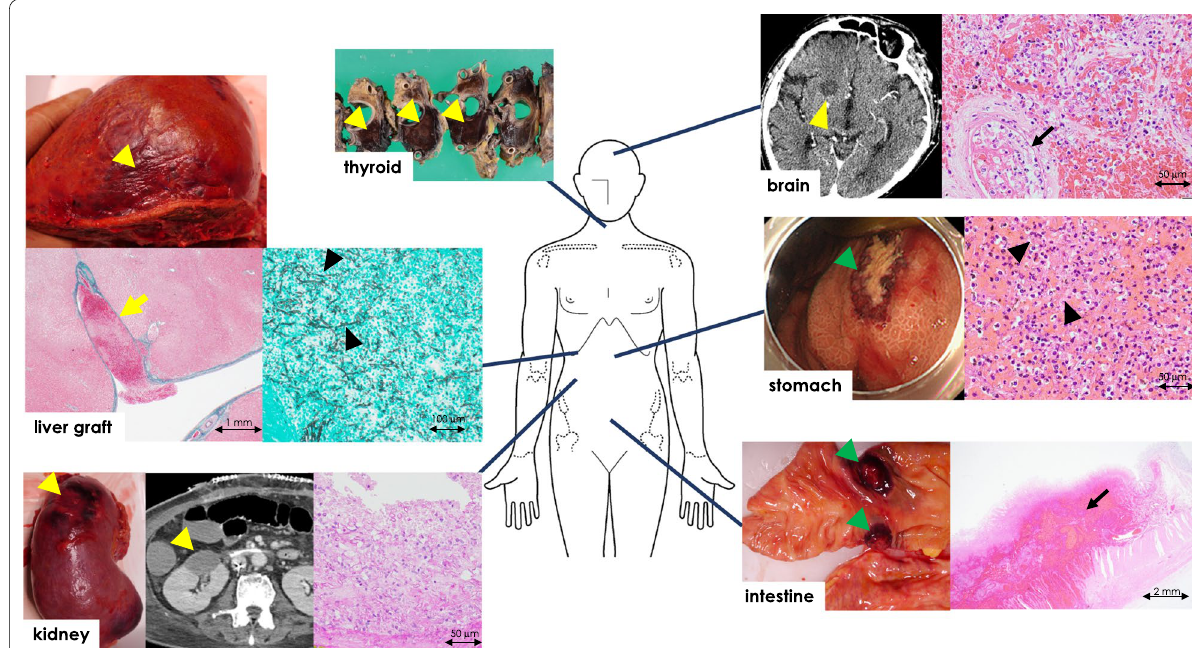
Fig. 4 Autopsy findings. The brain, thyroid, liver graft, and kidney have infarctions (yellow arrowheads). A thrombus filled with fungal hyphae stained by Grocott is detected in a branch of the portal vein in the liver graft (yellow arrow). The stomach and intestine have multiple ulcers (green arrows), pathologically represented as bleeding necroses. Many fungal hyphae (arrowheads) are seen in atrial thrombosis (arrows) and tissues of the brain, kidney, stomach, and